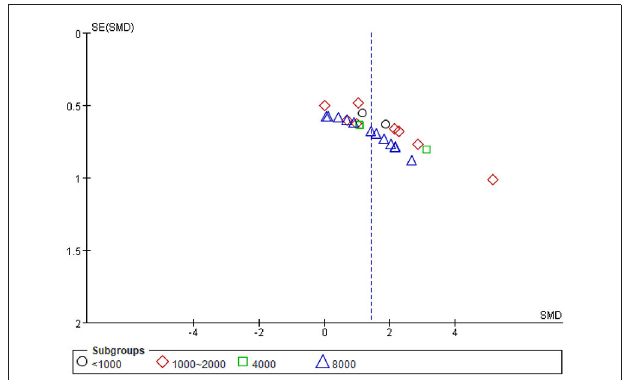
FIGURE 10 | Funnel plot for publication bias in the meta-analysis.